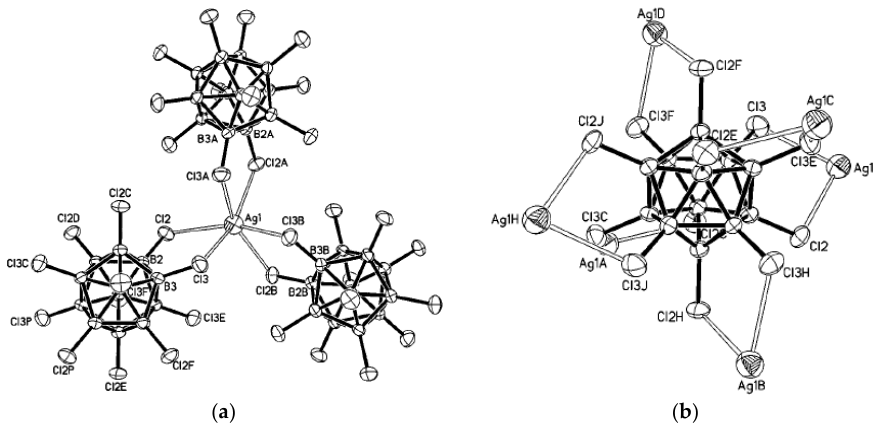
Figure 75. The coordination sphere of the Ag atom in {Ag[1-Me-1-CB 11 Cl 11 ]} n ( a ) and the coordination sphere around the carborane anion in {Ag[1-Me-1-CB 11 Cl 11 ]} n ( b ). Reprinted with permission from reference [99]. Copyright © (2000) American Chemical Society.